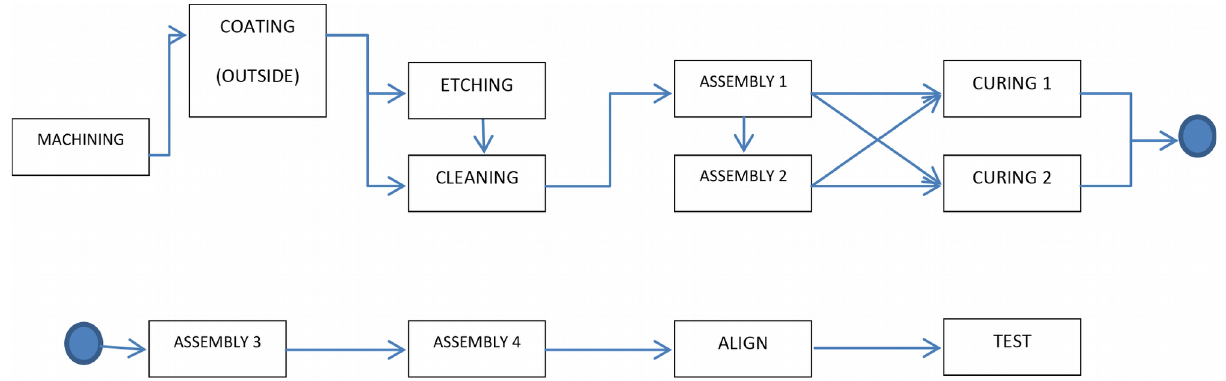
Figure 4. Base system processes and flows